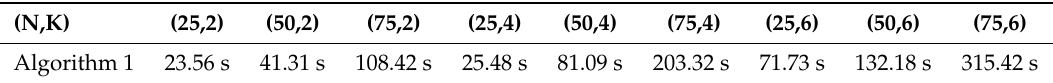
Table 3. Run time of Algorithm